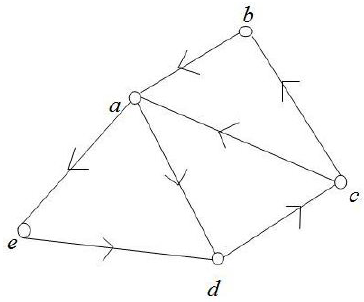
Figure 2. A directed graph with no start